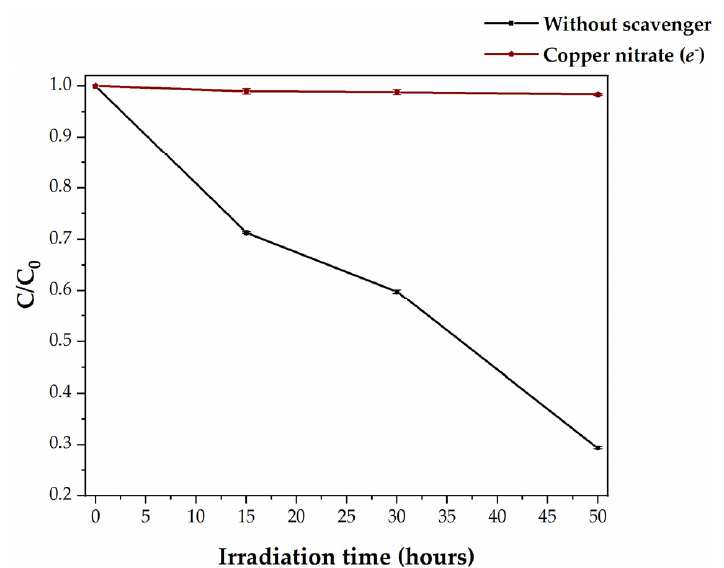
Figure 7. Visible-light photocatalytic degradation of HDPE MPs by C,N-TiO 2 in the absence and presence of copper nitrate as an e − scavenger.